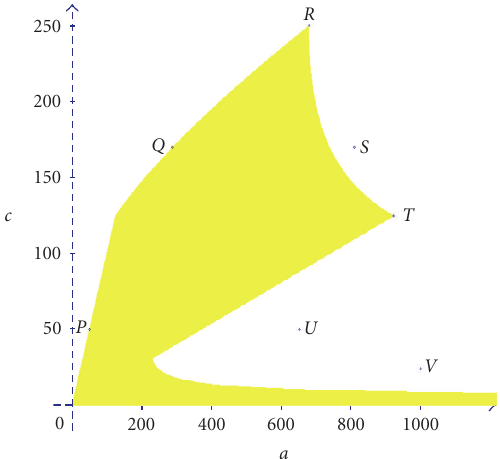
Figure 6.13 . Region of su ffi cient stability condition for (5.2): p = 0, h = 0 . 024, Δ = 0 . 008.